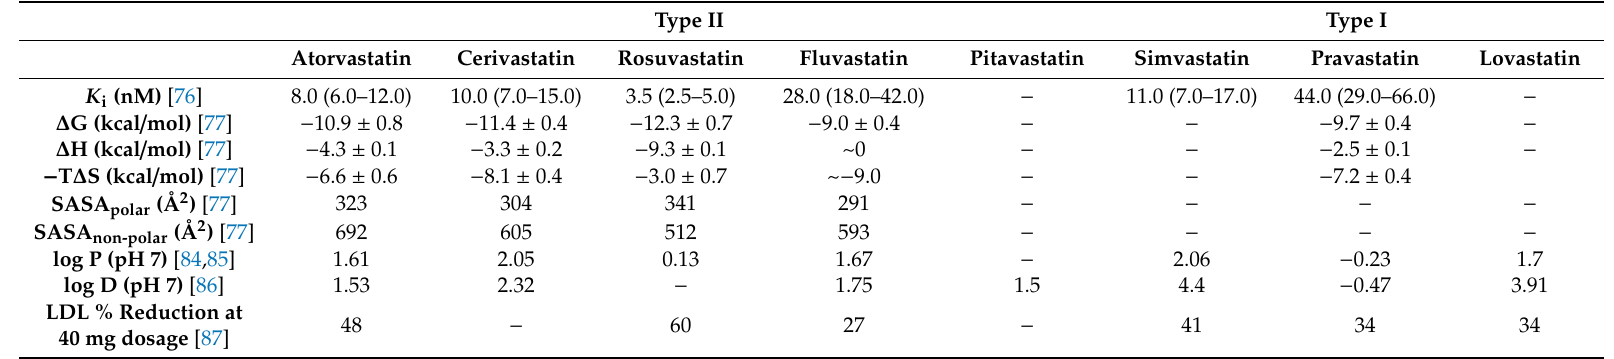
Table 1. Various measure of statin lipophilicity, e ffi cacy, and binding dynamics. Ki = enzyme inhibitor binding constant, loP and logD. ∆ G = Free-energy (kcal / mol) of SASA polar and SASA non-polar (Å 2 ) are the solvent-accessible surface area for the entropy estimation. LoP and LogD are partition coe ffi cients (water-octanol) at pH 7. E ffi cacy of statins as measured by LDL % reduction at 40 mg